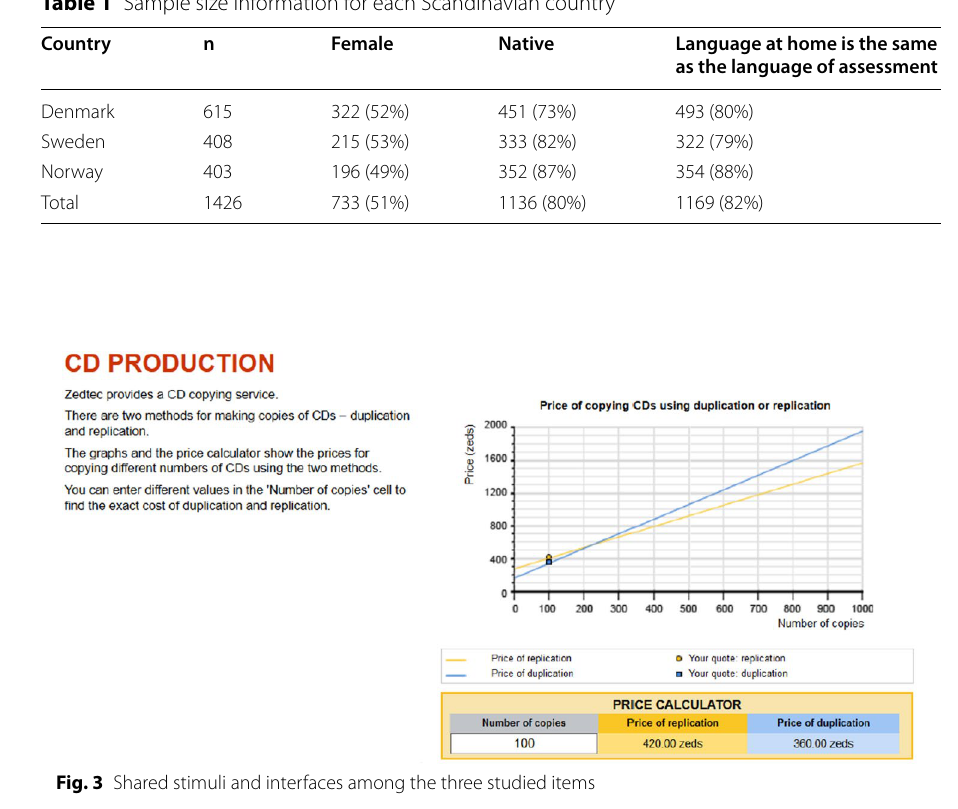
Table 1 Sample size information for each Scandinavian country Country n Female Native Language at home is the same